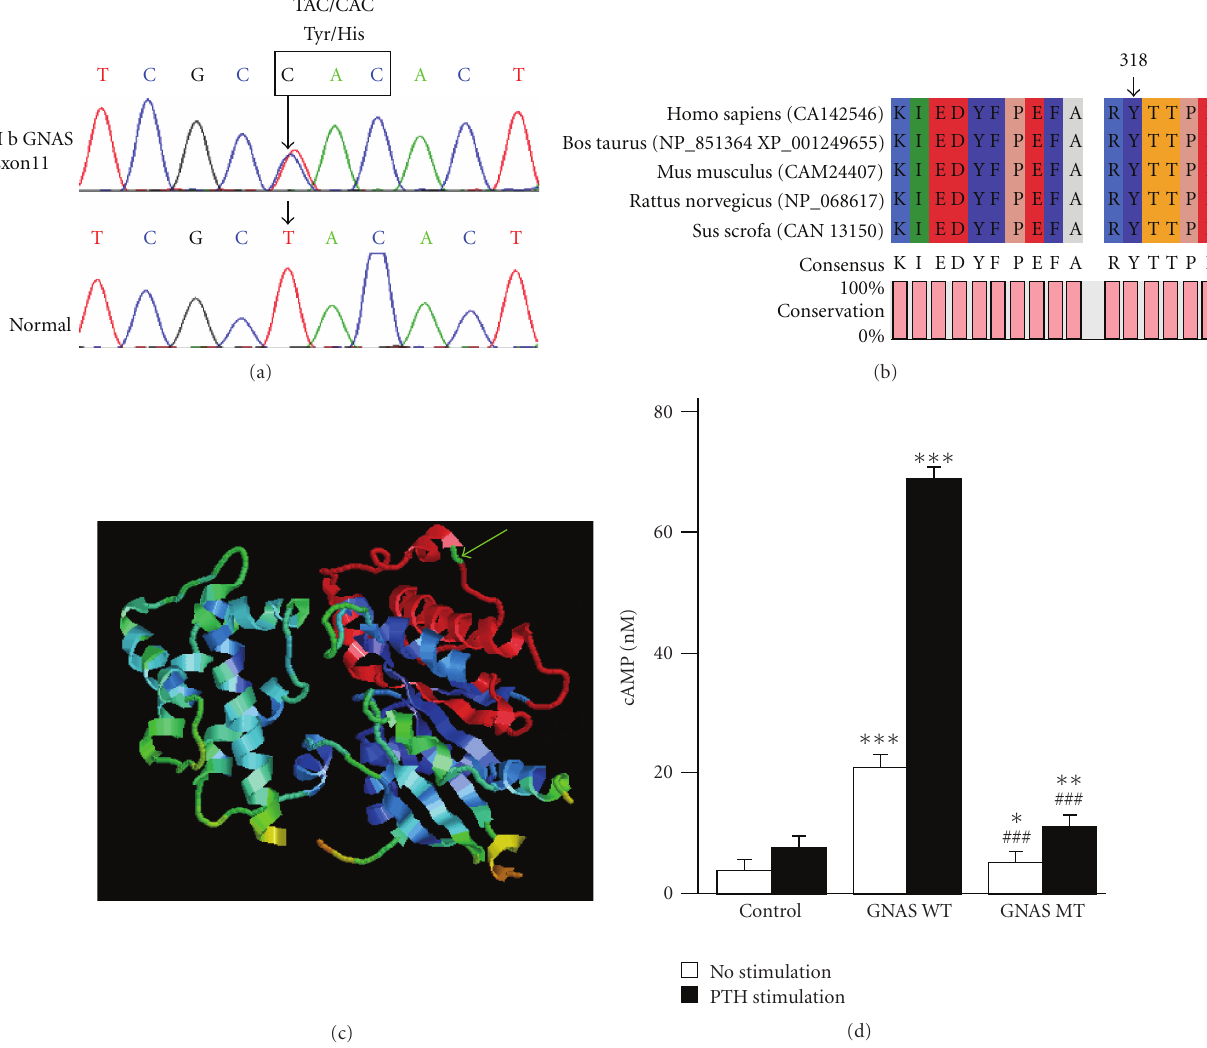
Figure 2: (a) Sequencing analysis of exon 11 in patient II b. The figure shows that the missense mutation at codon 318 results in a Tyr to His substitution. The same mutation was found in the proband’s mother, who is a ff ected by PPHP. (b) Gsa conservation analysis with CLC free, the result shows that Gsa codon 318 is in the highly conserved region. (c) The tertiary structure of Gsa, α 4- β 6 loop was shown in red, and Tyr-318 residue was the green point indicated by green arrow. (d) A cAMP assay was used to assess the Gsa function of GNAS WT and GNAS MT, with or without stimulation with PTH 1–34 (10 − 8 M) in OK cells. ∗ P < 0 . 05; ∗∗ P < 0 . 01; ∗∗∗ P < 0 . 001 (compared with control). ### P < 0 . 001 (compared with GNAS